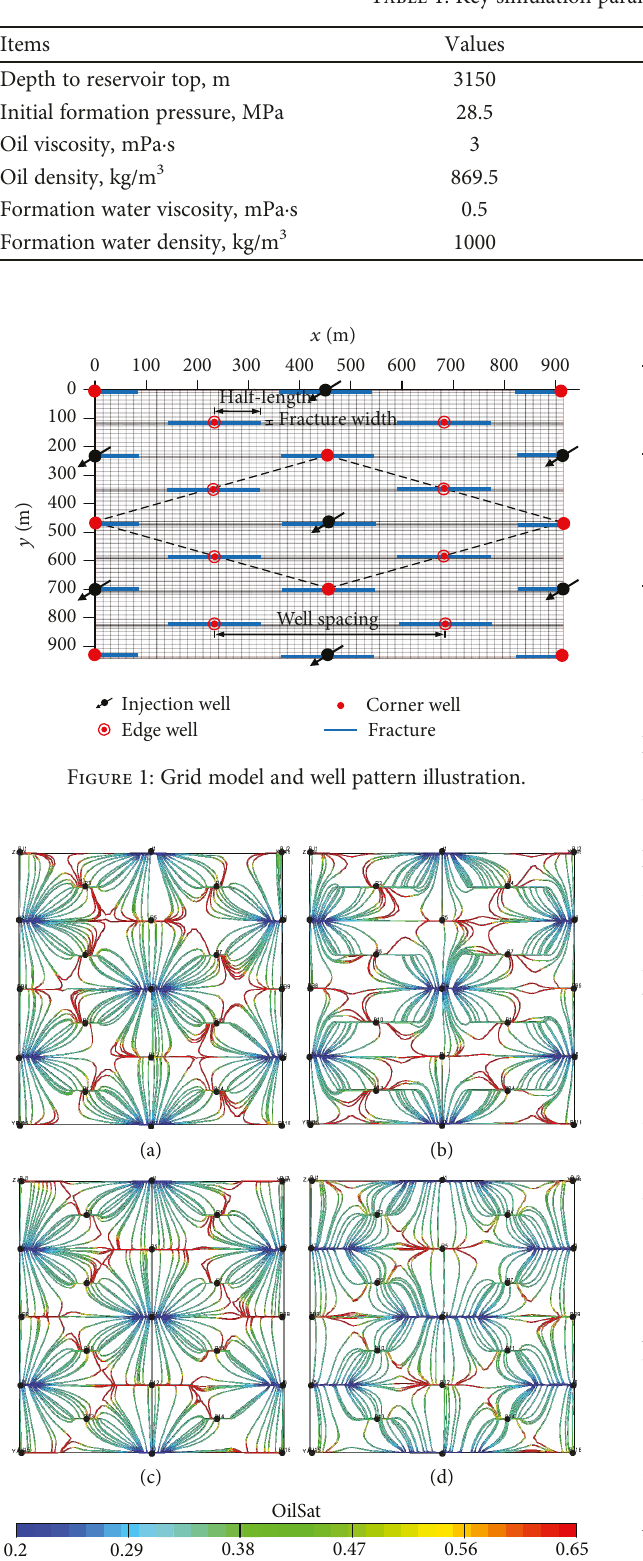
Table 1: Key simulation parameters used in the model.